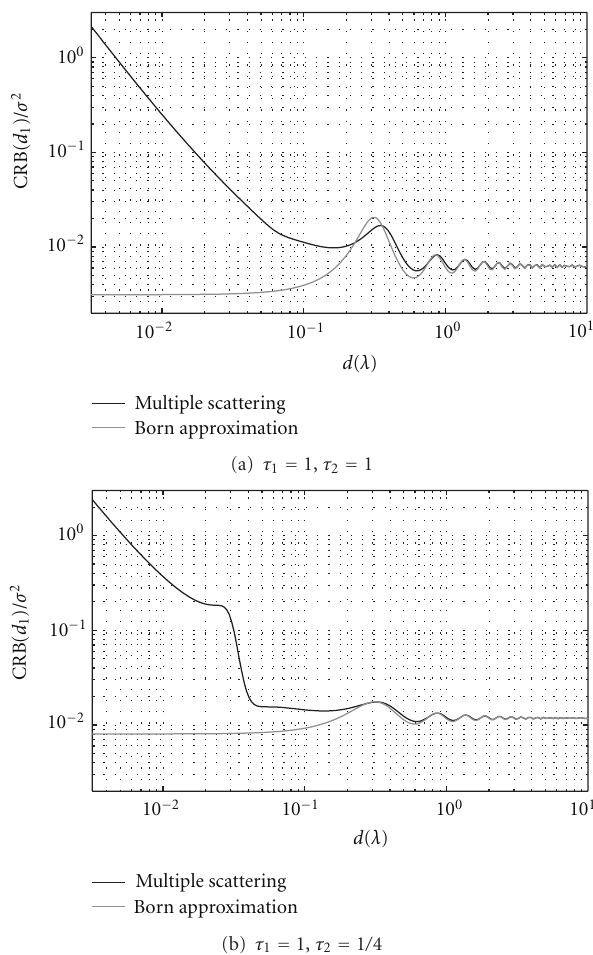
Figure 8: Average CRB( d 1 ) as a function of the scatterers’ separation d . The Fisher information on which the bound is based is averaged over 10 4 data corresponding to 100 uniformly-spaced incidence and scattering angles in the full interval [0, π ]. Two variations are shown: (a) equal ( τ 1 = 1 = τ 2 ) and (b) unequal ( τ 1 = 1 and τ 2 = 1 / 4) scatterer